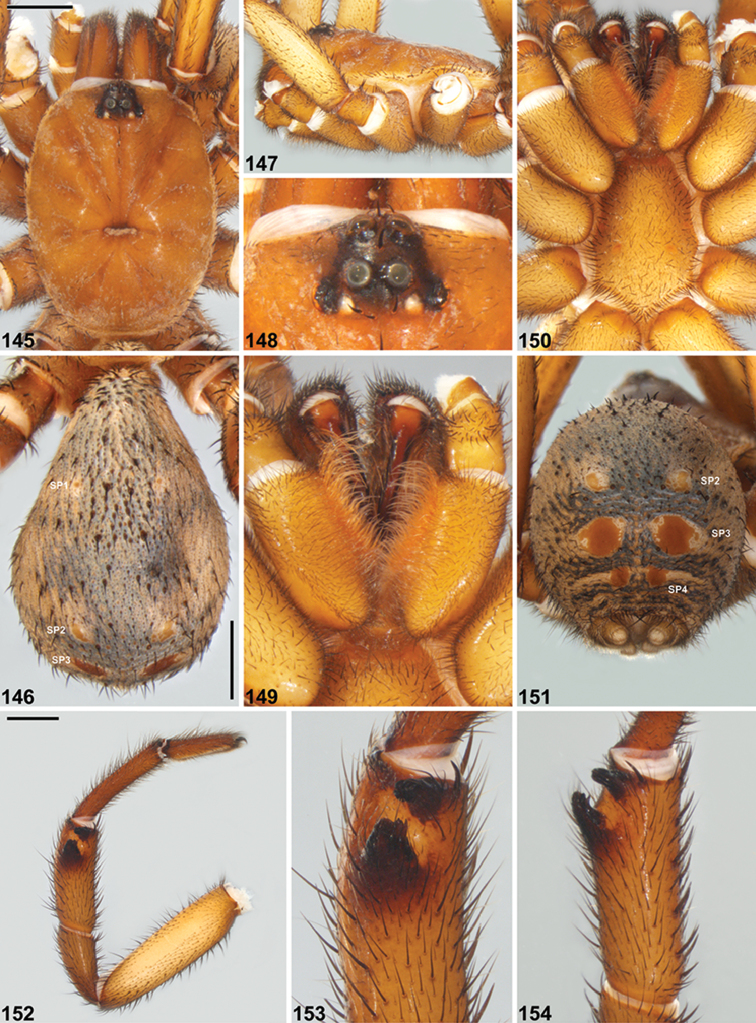

Idiosoma
formosum sp. n., male holotype (WAM T139470) from Mount Gibson Station (Western Australia; AVW), somatic morphology. 145–146 Carapace and abdomen, dorsal view 147 Carapace, lateral view 148 Eyes, dorsal view 149 Mouthparts, ventral view 150 Sternum, ventral view 151 Abdomen, posterior view 152 Leg I, prolateral view 153 Leg I tibia, clasping spurs, prolateral view 154 Leg I tibia, proventral view. Scale bars 2.0. SP1–4 = sigilla pairs 1–4.